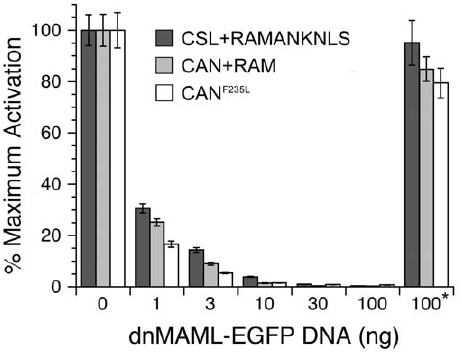
Figure 4. The CAN fusion molecule is fully competent for MAML interaction, suggesting that CAN maintains a native-like CTD:ANK interface. The interaction of the co-activator MAML with the CTD:ANK interface was assessed using dominant-negative MAML (dnMAML) to inhibit transcription. The CAN fusion molecule, in the presence of RAM (light gray), is equally susceptible to dnMAML as CSL and RAMANKNLS in trans (dark gray), suggesting that the ANK:CTD interface is formed similarly in both arrangements. The CAN F235L fusion molecule, in the absence of RAM (white), is equally susceptible to dnMAML as both arrangements described above. EGFP alone (*) does not significantly perturb CSL/CAN-mediated transcriptional activation.